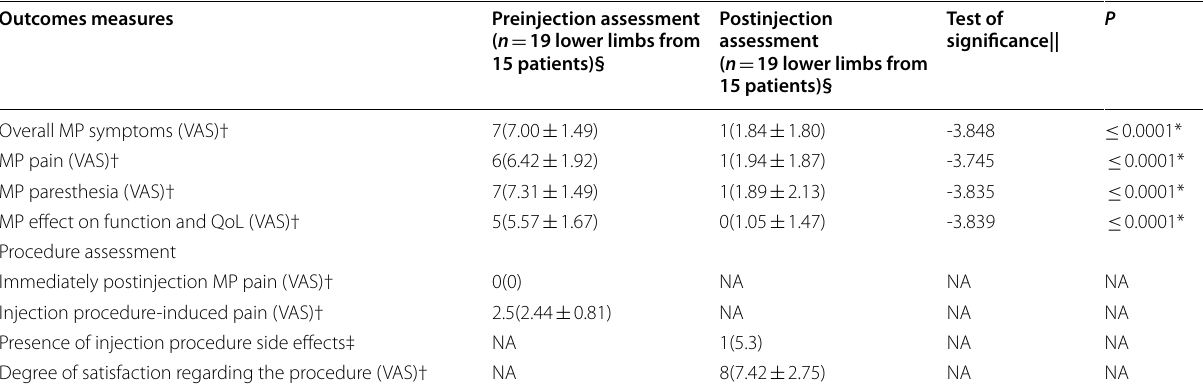
Table 2 Comparison between the preinjection and the postinjection assessments regarding outcomes measures and procedure